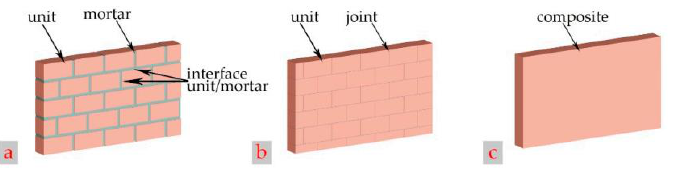
Figure 4. Modeling approaches for masonry structures: ( a ) detailed micro-modeling approach, ( b ) simplified micro-modeling approach, and ( c ) macro-modeling approach.